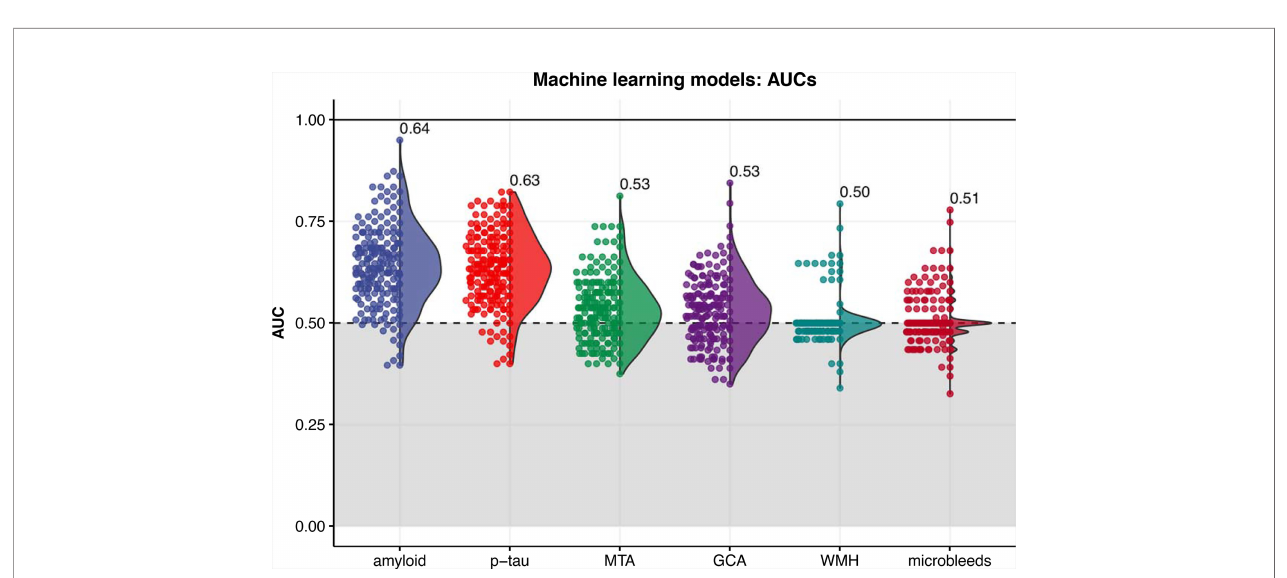
FIGURE 3 | Distribution of area under the receiver-operating curves (AUCs) resulting from 200 iterations of the machine learning classi fi cation models (XGBoost algorithm) for each outcome. The labels indicate the mean AUC over 200 iterations. MTA, medial temporal atrophy; GCA, global cortical atrophy; WMH, white matter hyperintensities.